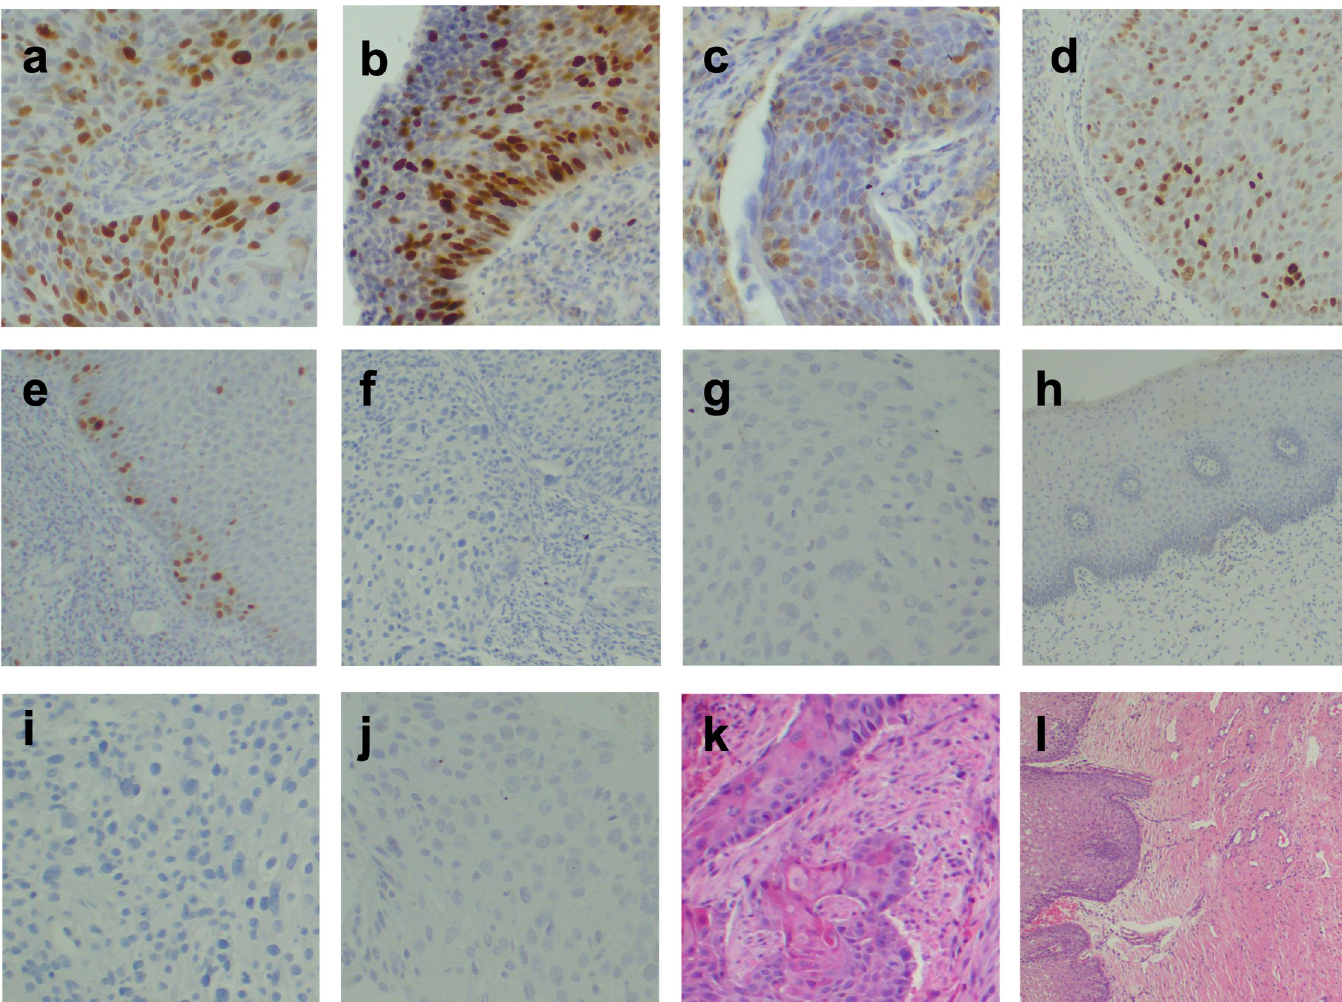
Fig 1. Monographs. Nucleus and cytoplasm were positively stained for ( a-b ) p16 at 200x for cancerous and precancerous cervical lesion respectively. Nucleus positively stained for ( c-d ) TOP2A at 200x for cancerous and precancerous cervical lesion respectively, and ( e ) TOP2A at 40x for a benign cervical lesion. Nucleus and cytoplasm negatively stained for ( f-g ) p16 at 100x and 200x for cancerous and precancerous cervical lesion respectively, and ( h ) p16 at 200x for a benign cervical lesion. Nucleus negatively stained for ( i-j ) TOP2A at 200x for cancerous and precancerous cervical lesion respectively; ( k-l ) H&E staining at 100x and 40x for squamous cell carcinoma and normal cervix